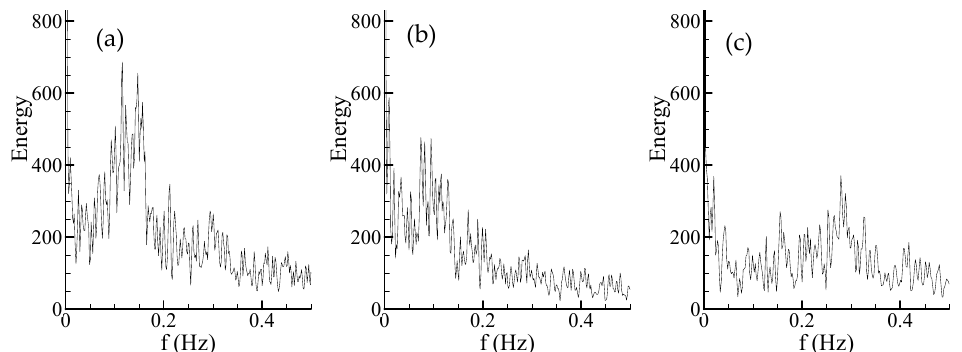
Figure 6. The frequency spectra of the pulling load corresponding to the three figures in Figure 4 (( a ) still water, ( b ) U = 1.0 m/s and ( c ) U = − 1.0 m/s). Table 2. Measured pulling forces and calculated force coefficients. (ACM s g = 3.23, µ = 0.25). Test U (m/s) F pull , 1 (N) F pull , 2 (N) T1